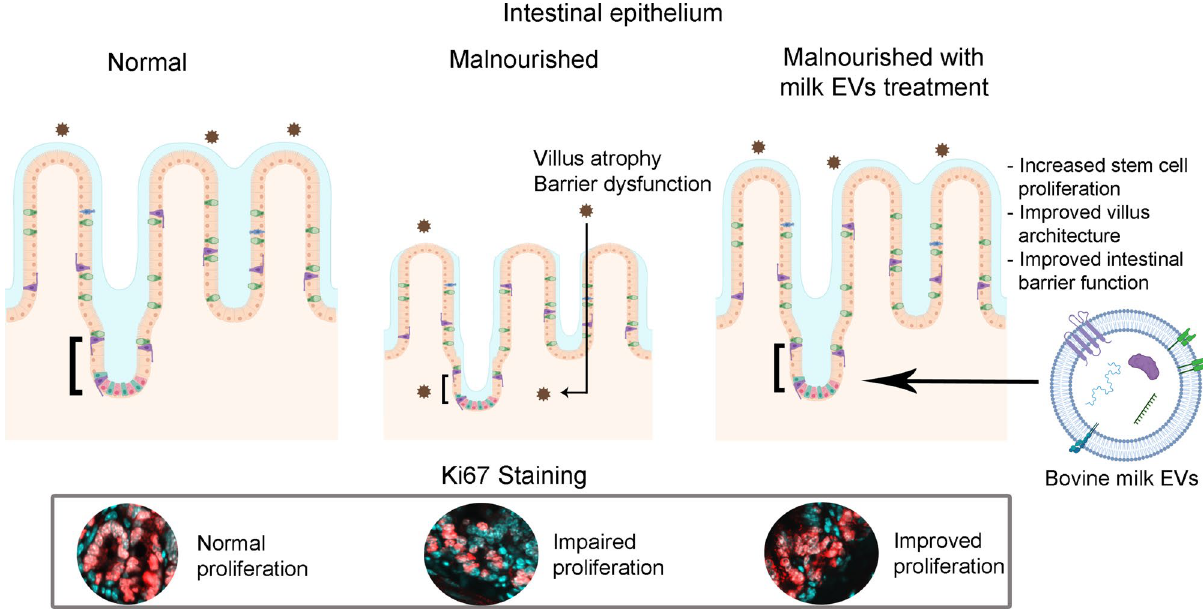
Figure 7. Conceptual model. Framework representing a mode of action of milk EVs in the restoration of barrier dysfunction and the repair of structural injury seen in the small intestinal villi of malnourished animals. Milk EV-treatment induced repair, at least in part, through increased stem cell proliferation in intestinal crypts. This figure was in part created with BioRender and was licenced for use in publication (created with BioRender.